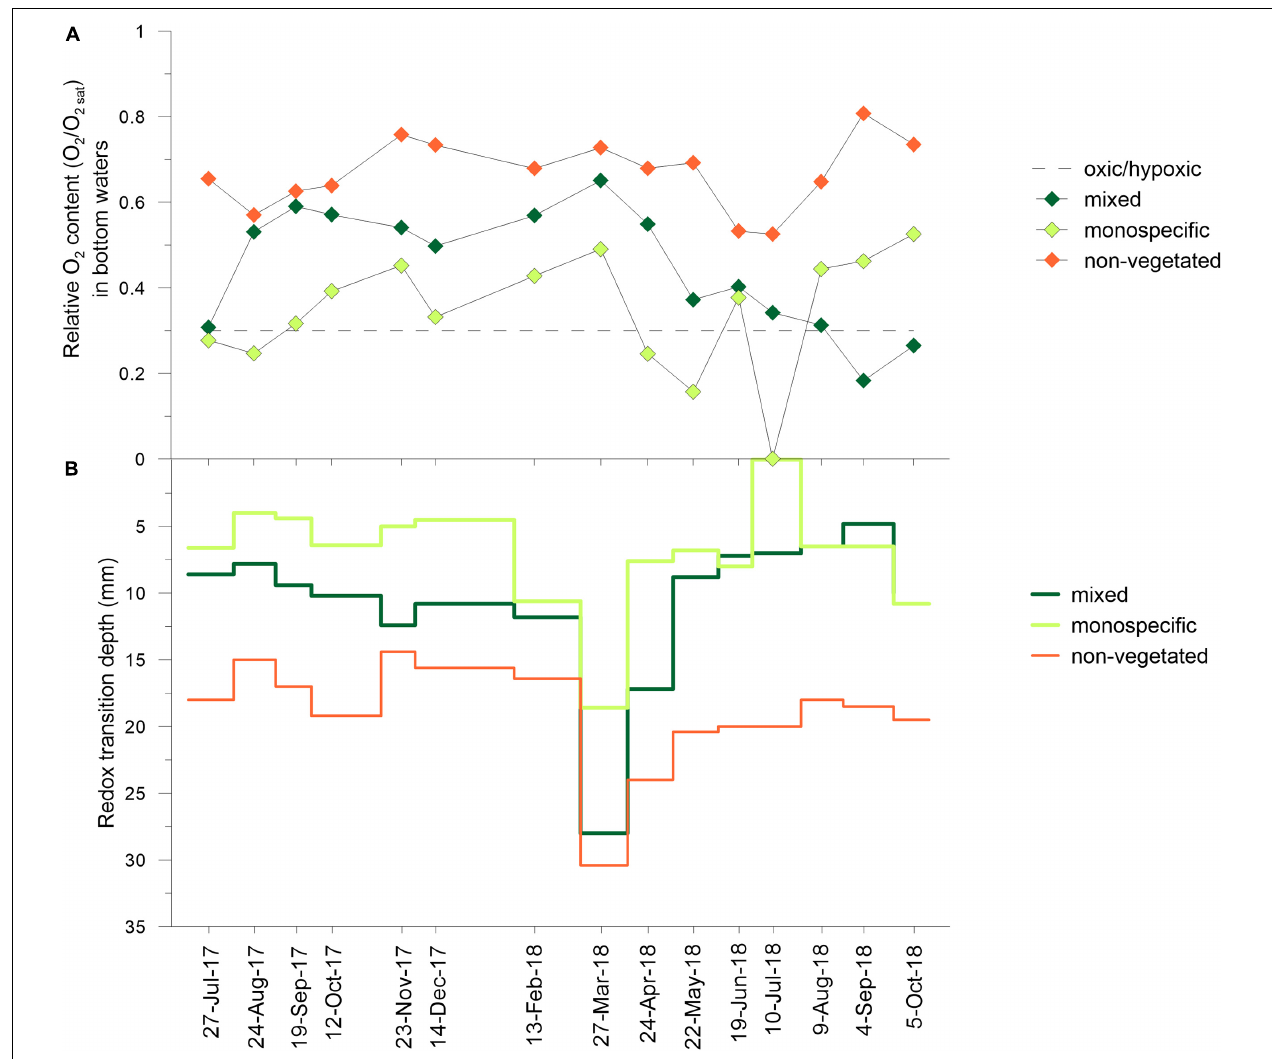
FIGURE 6 | Oxygen content relative to saturation level (O 2 /O 2 sat ) in bottom waters (A) and redox transition (Eh ≤ 0) depths in vegetated (underlying mixed and C. cylindracea monospecific settlements) and non-vegetated sediment (B) during investigated period. O 2 at the saturation level was calculated according to the temperature and salinity measured in seawater at the sampling dates; O 2 /O 2 sat at the hypoxic frontier was recalculated according to data from Vaquer-Sunyer and Duarte